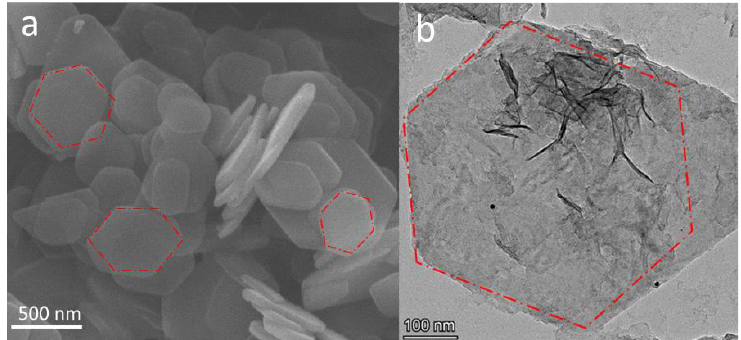
Figure 2. ( a ) SEM image of crystalline ZrP powder, and ( b ) TEM image showing the hexagonal ZrP